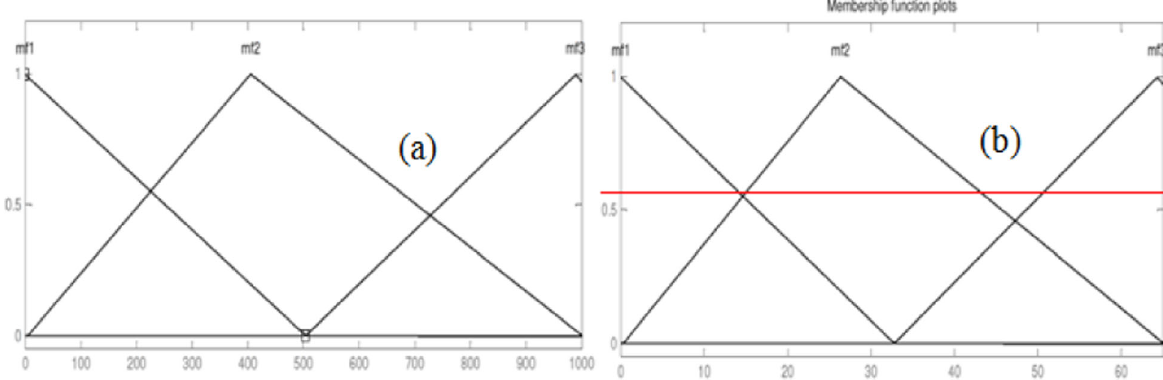
Fig. 11 Membership functions: (a) solar irradiance (b) PV cell